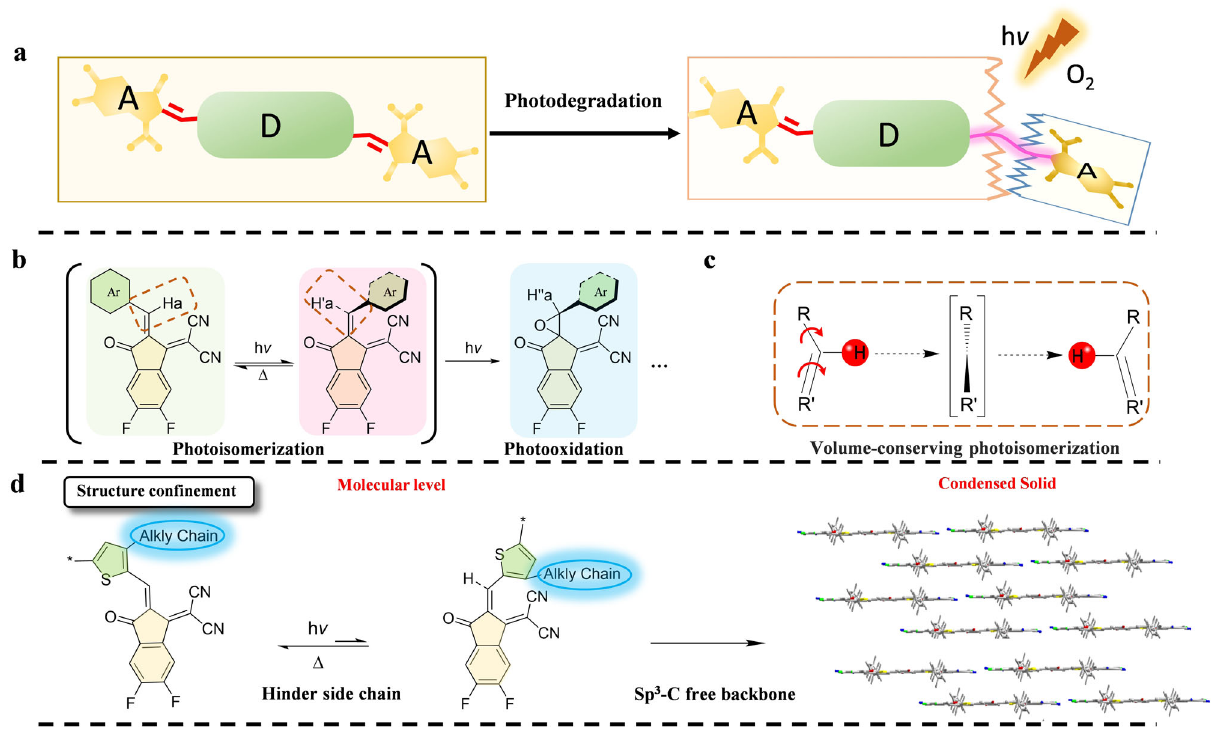
Fig. 1 Structural factors on determining the photostability of A – D – A NFAs. a Structural sketch and the photodegradation of typical A – D – A NFAs. b Photochemical reaction. c The plausible isomerization mechanism of the vinyl group in A – D – A NFAs. d Structural con fi nement from the molecular level to macroscopic condensed solid for enhancing photostabilities of